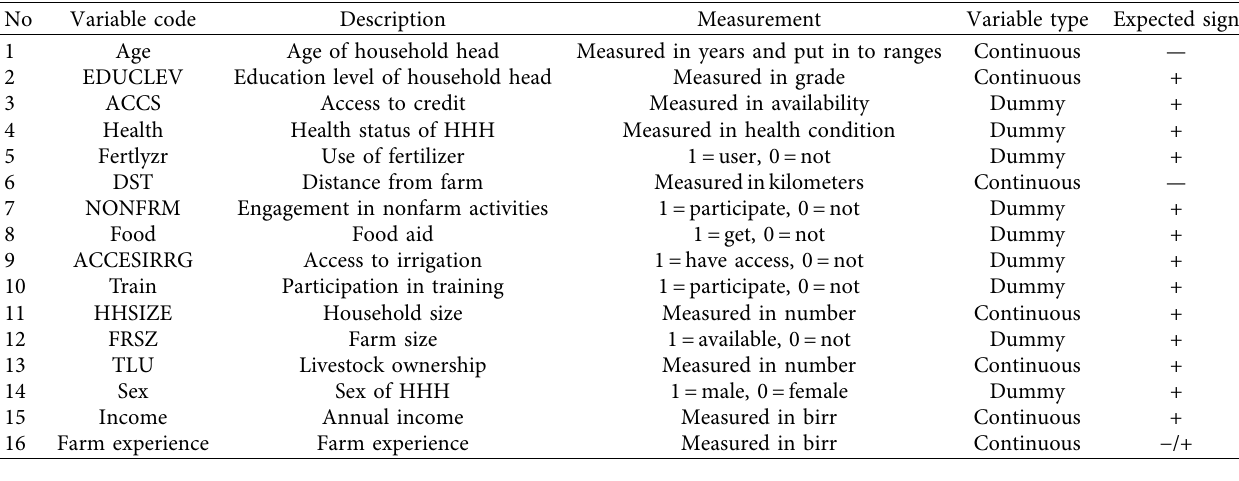
Table 2: Description of dependent and independent